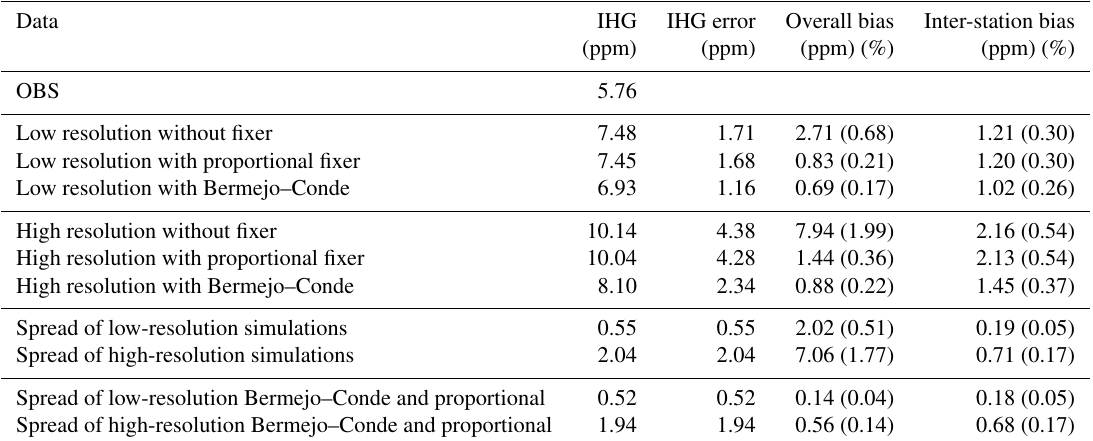
Figure 6. Difference in mean XCH 4 (ppb) between (a, b) the simulations using the proportional mass fixer and the simulation without mass fixer at high and low resolution respectively; (c, d) the simulation with Bermejo–Conde and the simulation without mass fixer at high and low resolutions respectively. The period covered and the marking of the observation sites are the same as in Fig. 4. See Table 2 for a list of the TCCON site coordinates. Table 4. XCO 2 inter-hemispheric gradient (IHG) error (MODEL − OBS) statistics for simulations with different resolution and different mass fixers with respect to observations from